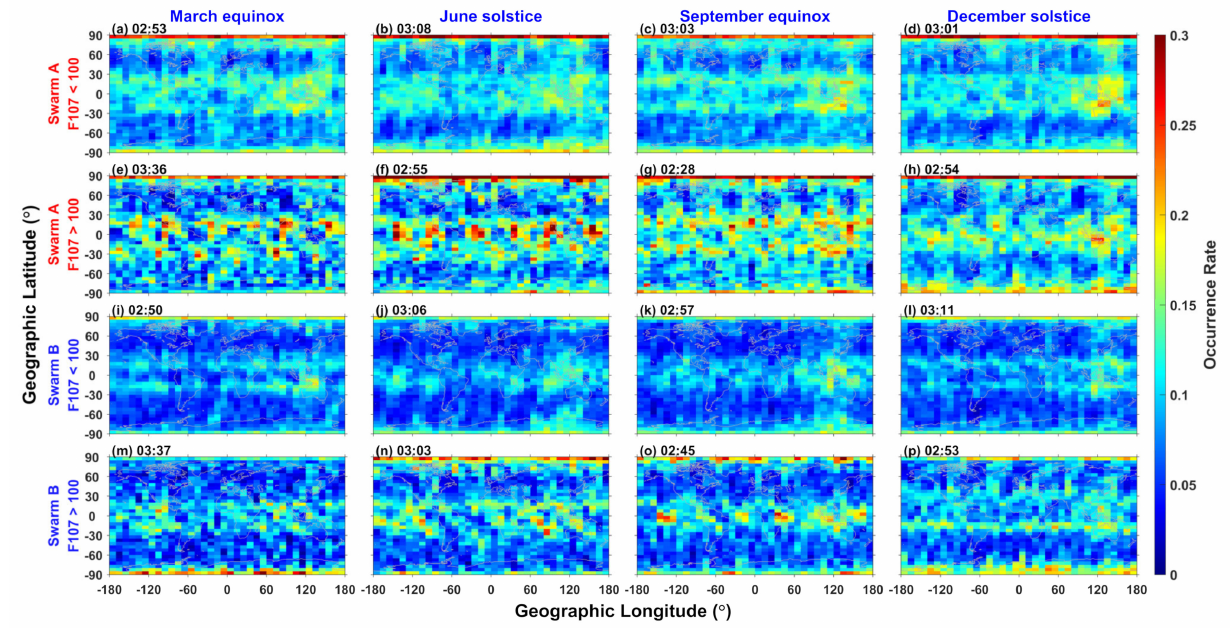
Figure 6. Same as Figure 2 but for S4c after midnight. S4c denotes the approximate S4 index calculated from the carrier-to-noise ratio. The panels from top to bottom show results for Swarm A (F107 < 100, ( a – d )), Swarm A (F107 > 100, ( e – h )), Swarm B (F107 < 100, ( i – l )), and Swarm B (F107 > 100, ( m – p )), from left to right show results at March equinox, June solstice, September equinox, and December